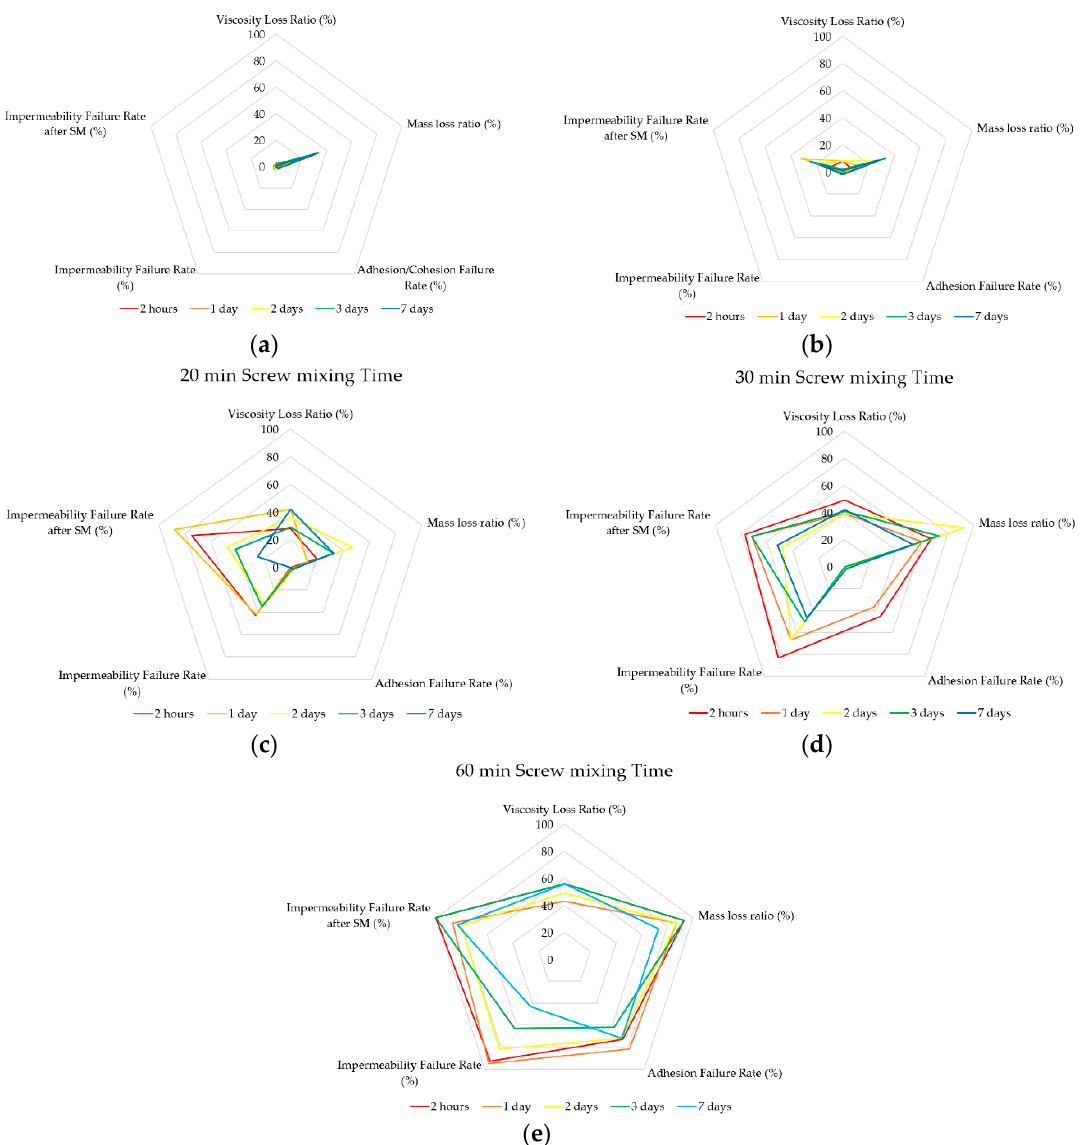
Figure 13. Radar charts for comparative evaluation of overall waterproofing performance; ( a ) results for no screw mixing; ( b ) results for 10 min of screw mixing; ( c ) results for 20 min of screw mixing; ( d ) results for 30 min of screw mixing; ( e ) results for 60 min of screw mixing.